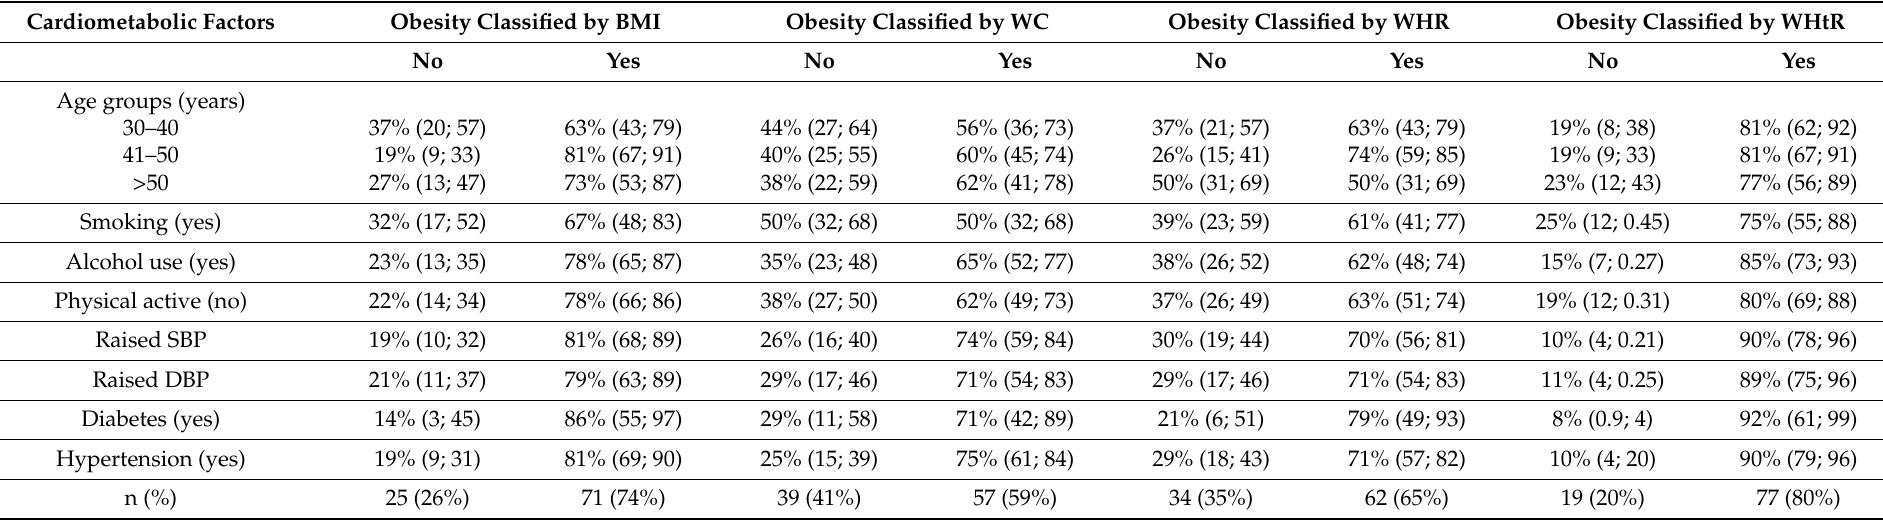
Table 2. Prevalence of cardio-metabolic factors distributed by obesity amongst logistic company truck drivers. Cardiometabolic